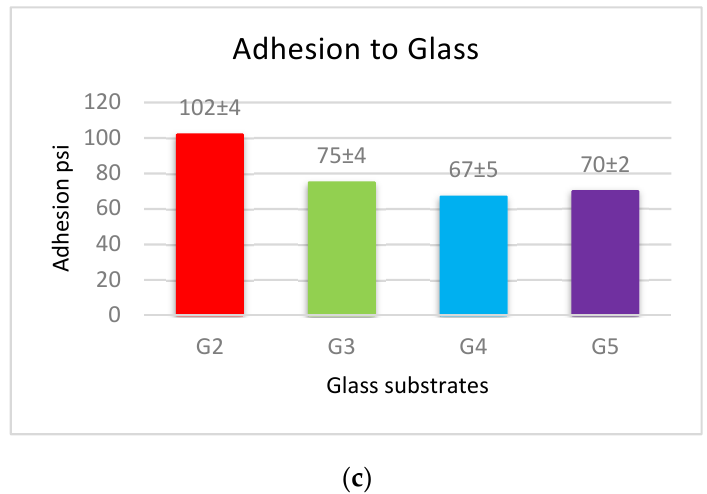
Figure 6. The adhesion force between ( a ) steel, ( b ) Al, and ( c ) glass substrates, and PVDF alone and PVDF–Al 2 O 3 coatings.